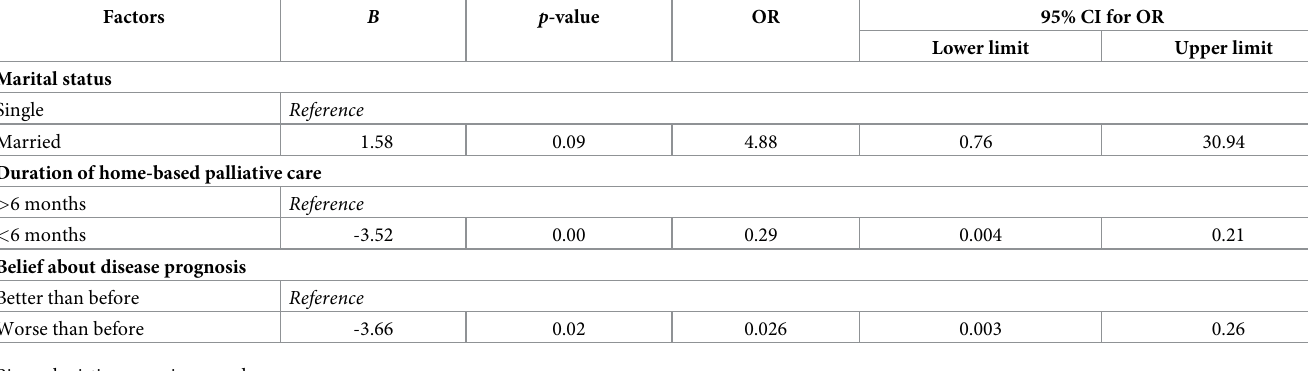
Table 6. Predictors of quality of life (QoL) among cancer patients considering the below average as reference (n =